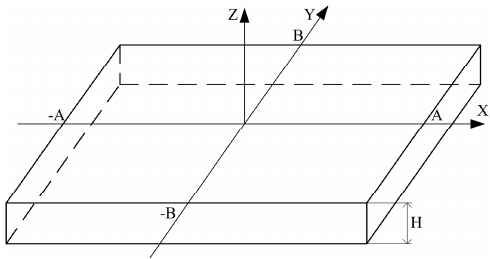
Figure 3. The schematic drawing of the pressure sensitive diaphragm.